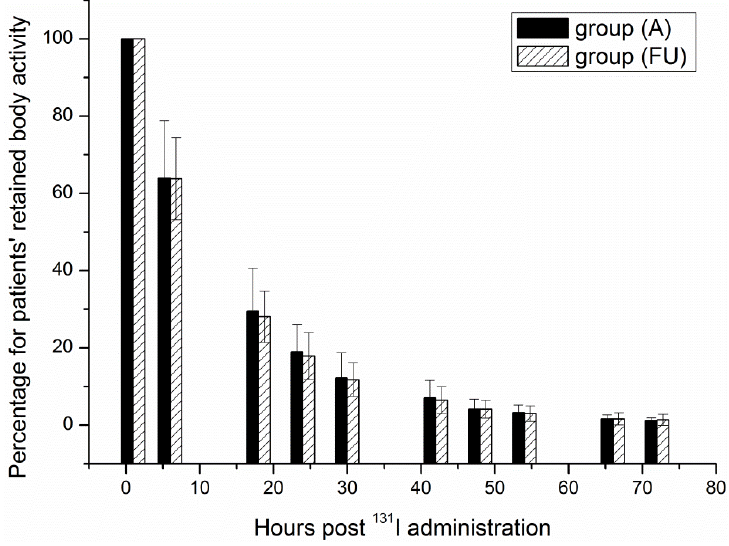
Figure 3. Retained body activity plotted as a function of hours post 131 I